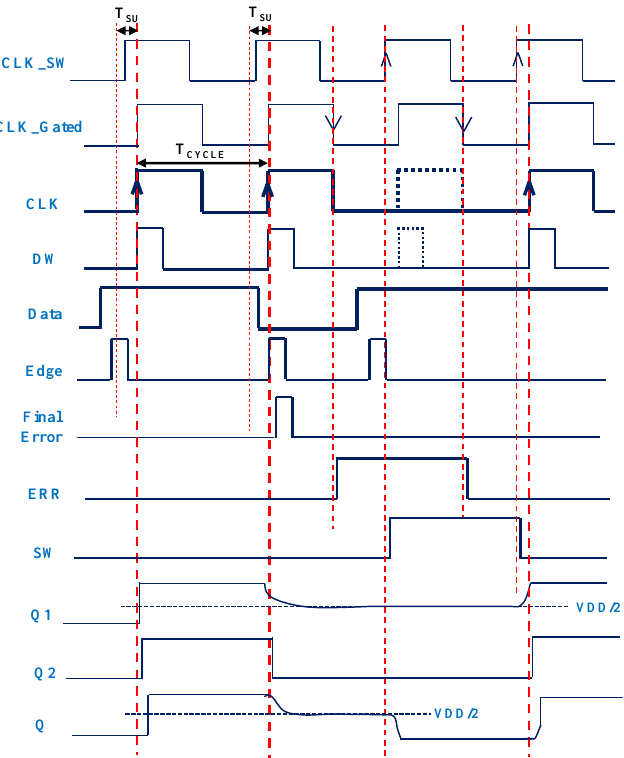
Figure 4. Timing behavior of the proposed